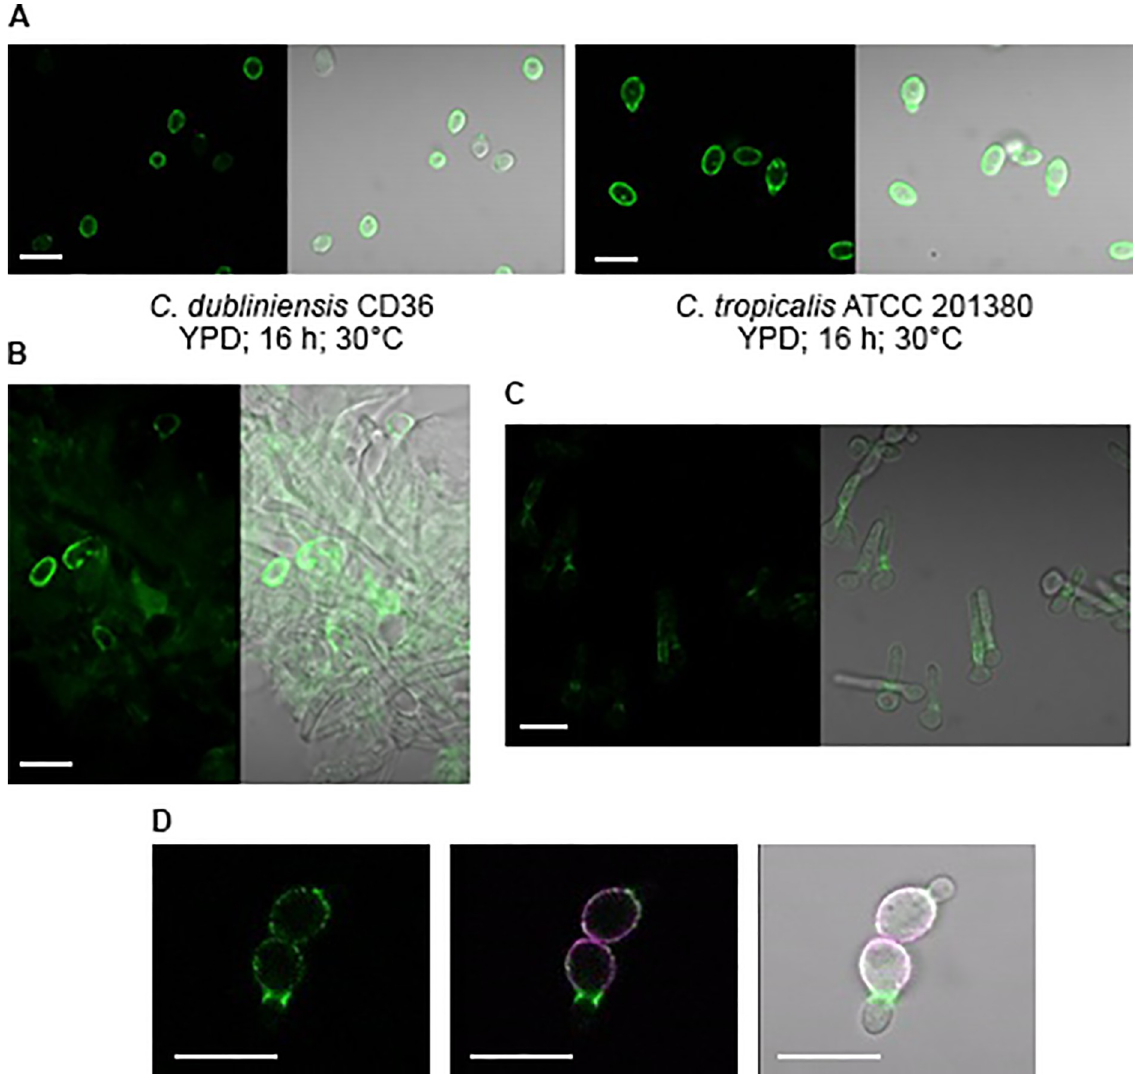
Fig 3. Immunolabeling of Candida cells with anti-Als2 MAb 2-C6. (A) C . dubliniensis CD36 and C . tropicalis ATCC 201380 yeast cells grown in YPD medium for 16 h at 30˚C. Both species were immunolabeled with anti-Als2 2-C6 suggesting a conserved epitope among the species. (B) Anti-Als2 immunolabeling of C . albicans CAI12 cells recovered from a murine model of oral candidiasis. Some Als2-positive yeast cells were located although they were rare in vivo . Als2-positive hyphae were not observed. (C) Various presentations of Als2 localization depending on growth conditions. C . albicans strain CAI12 was grown in YPD medium for 16 h at 37˚C, washed, counted, and resuspended in RPMI medium for 2 h at 30˚C. On some germ tubes, Als2 was localized diffusely along the germ tube length while on other cells, Als2